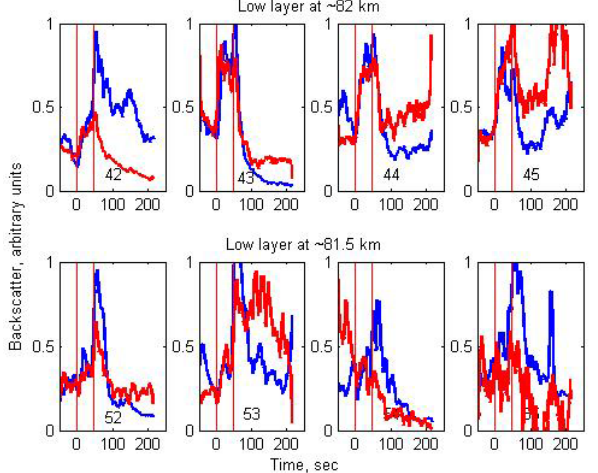
Figure 8. The OCC for the same four cycles for each of two differ- ent layers at heights 86 and 85km shown on a linear scale from 0 to 1. The OCCs for each cycle have been normalized to coincide at t = 0. VHF is blue; MORRO is red. The heater is on between the two vertical red lines. Heater cycle numbers are given at the bottom of each